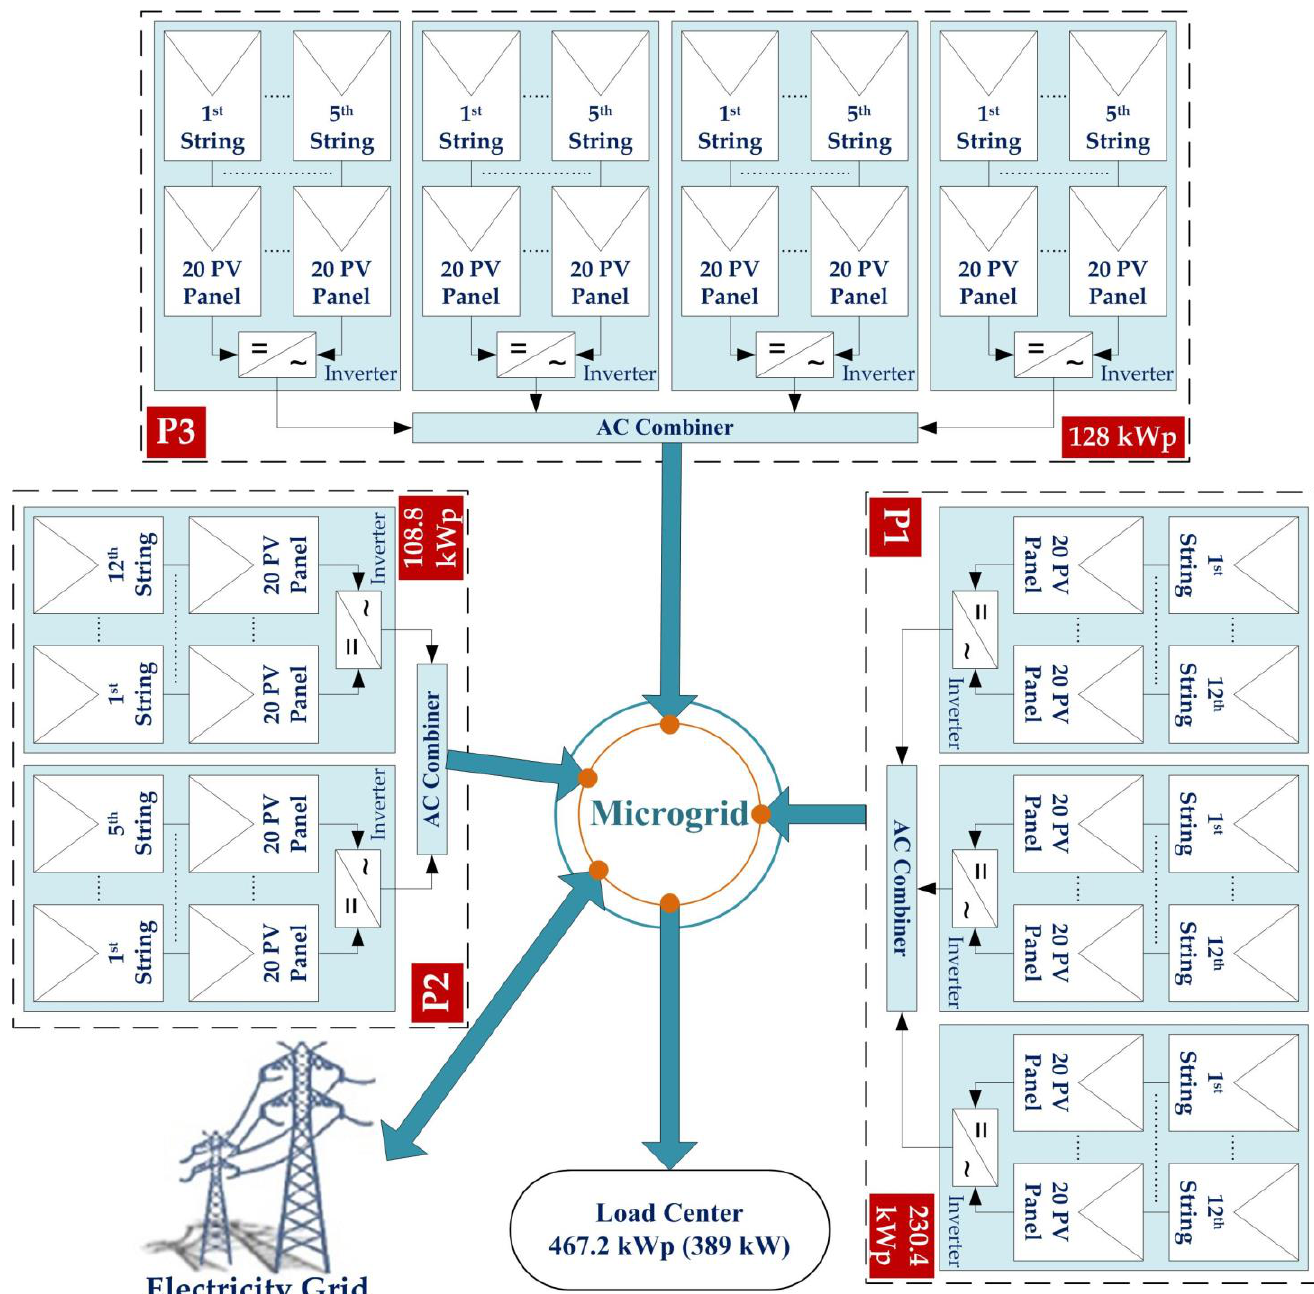
Figure 2. Developed electrical microgrid scheme based on solar PV system (1460 no. of PV panels (320 Wp) = 467.2 kWp (389 kW)).